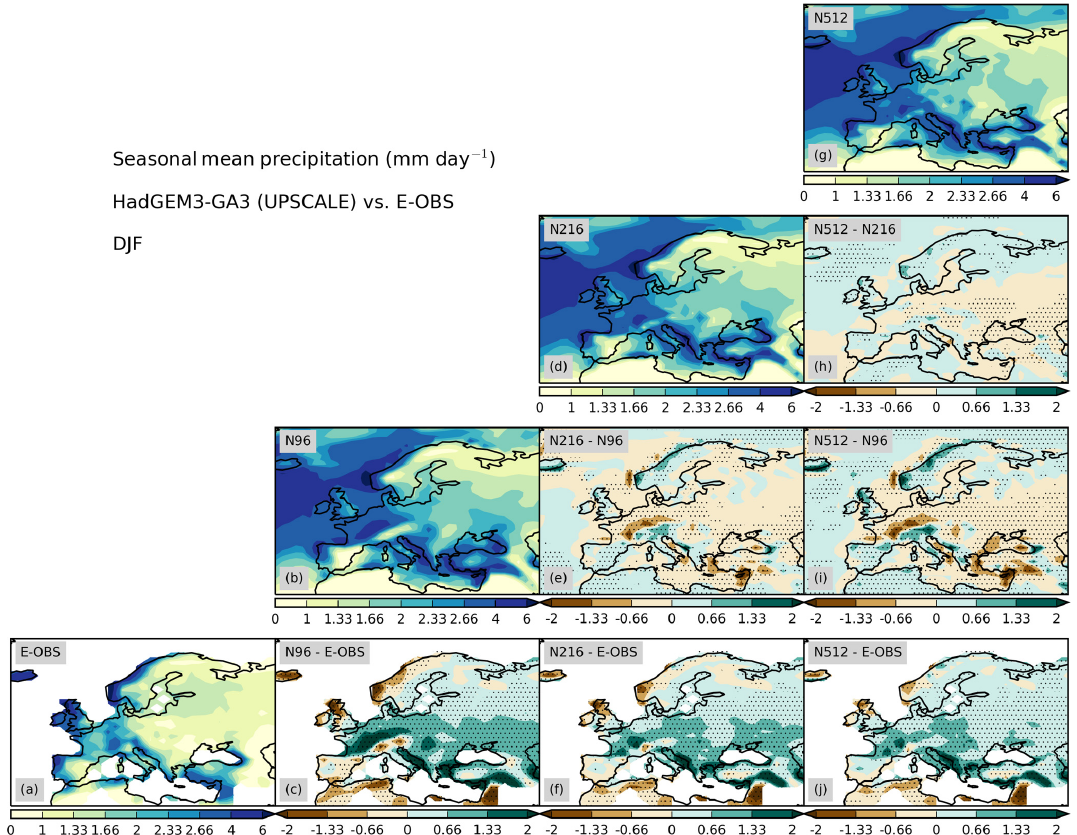
Figure 8. Winter (December–February) mean precipitation. (a) Observations (E-OBS), (b, d, g) model (HadGEM3-GA3.0) at resolutions N96, N216, and N512, (c, f, j) model biases with respect to E-OBS, and (e, h, i) differences between model resolutions. Stippling shows statistically significant